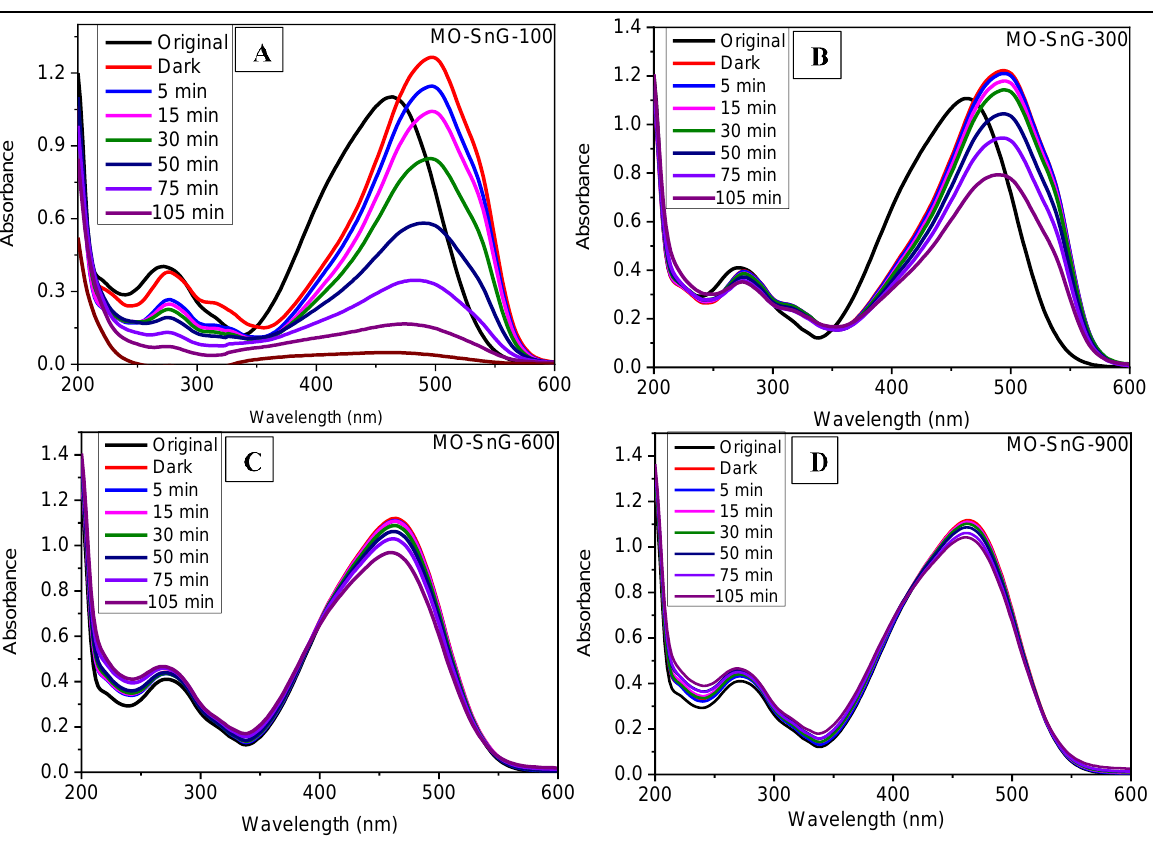
Figure 6. Degradation kinetics of methyl orange with SnO 2 NPs calcined at 100 °C ( A ), 300 °C ( B ), 600 °C ( C ), and 900 °C ( D ).